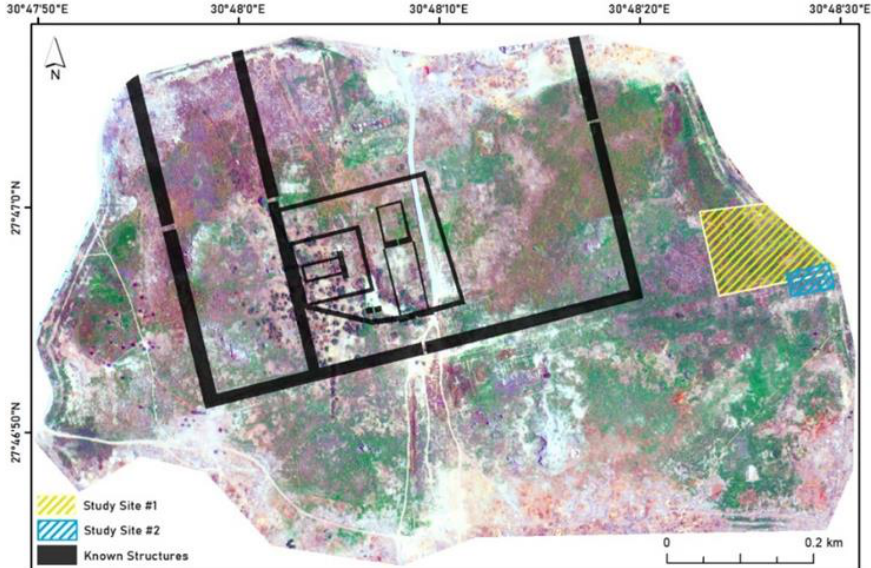
Figure 11. The study area image in RGB, the digitized structures from previous excavations [32], as well as the two newly detected sites in the eastern section of Hermopolis, located outside the excavated zones.